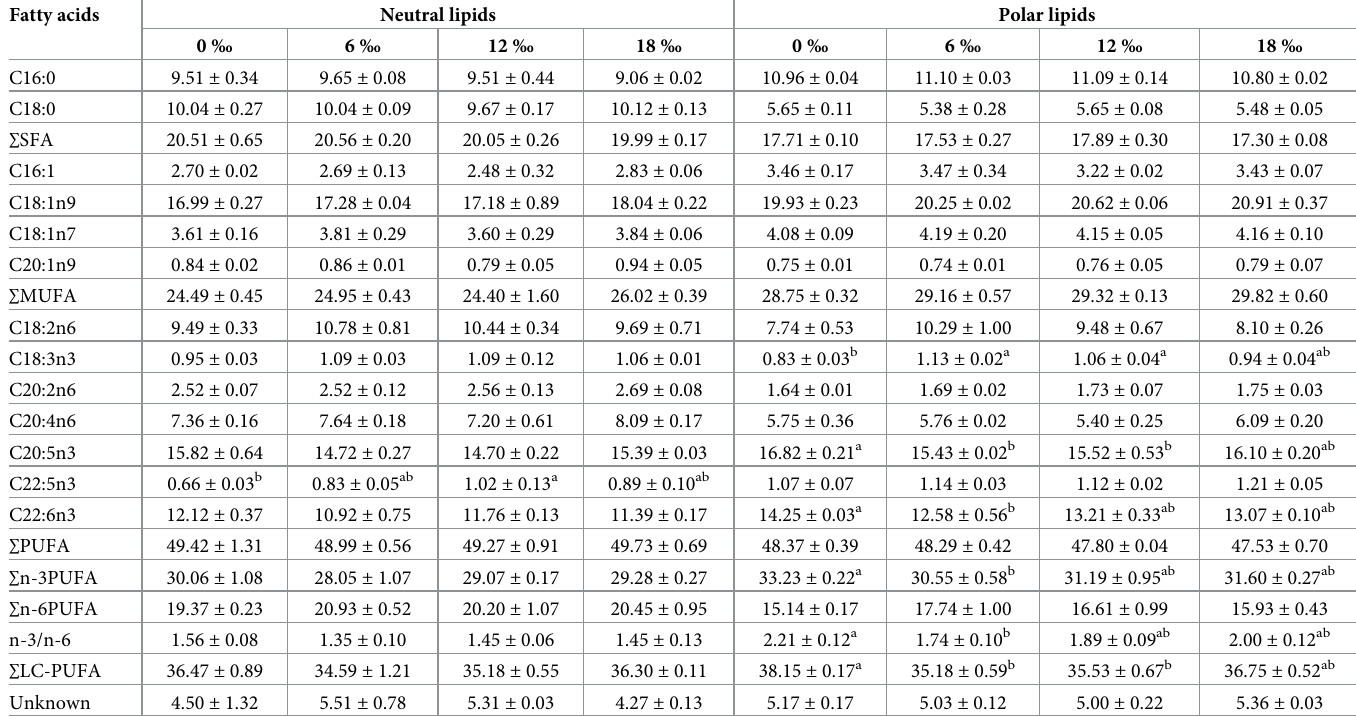
Table 7. The principal fatty acid profiles (% total fatty acids) of the neutral lipids and polar lipids in the muscles of adult female E . sinensis . Fatty acids